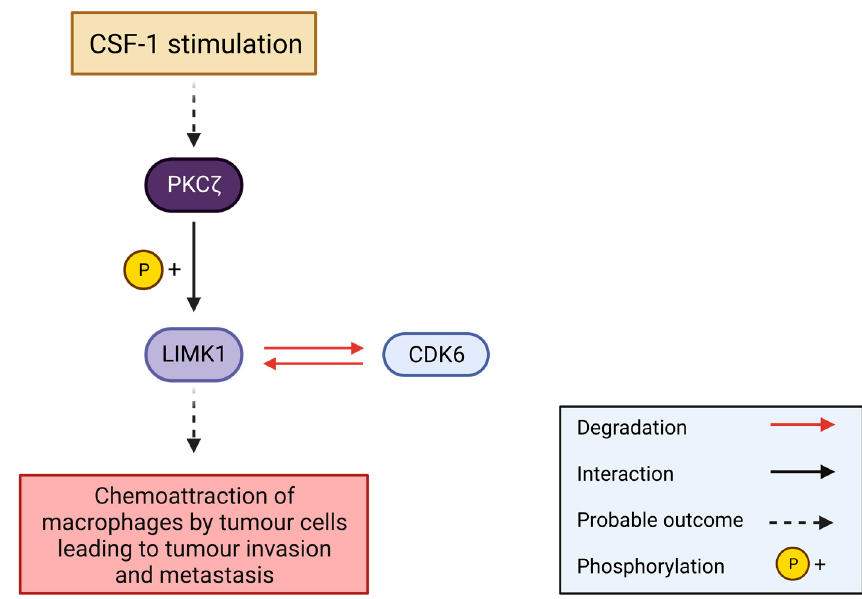
Figure 7. LIM kinases implication in the development of